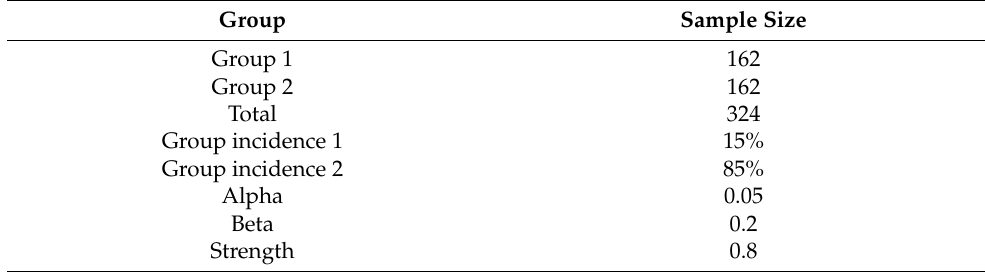
Table 1. Display of study strength–sample size. Group Sample Size Group